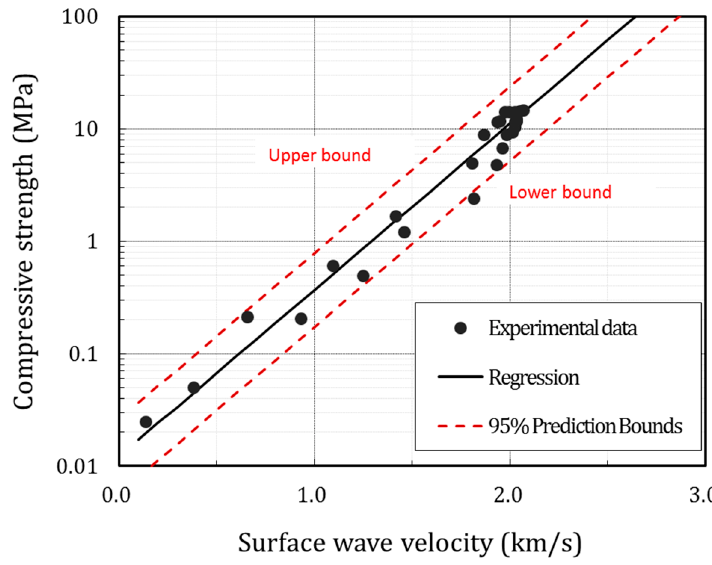
Figure 14. Fitted formula with the 95% prediction bound (MIX1). Table 4. Temperature coefficient, (cid:1863) , for mixtures 1–4.